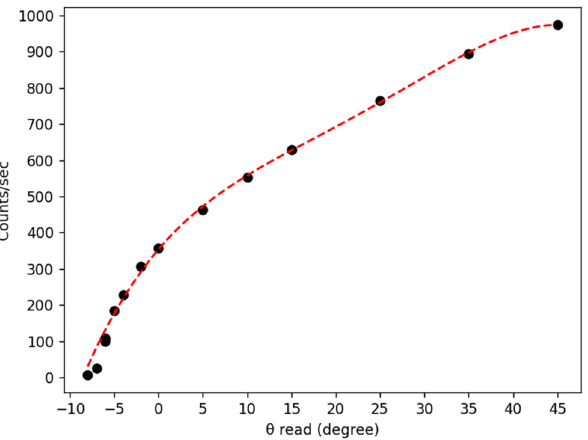
Figure 3. Detected counts per second for Ar 17+ at 170 keV colliding with a Si sample at various incidence angles.